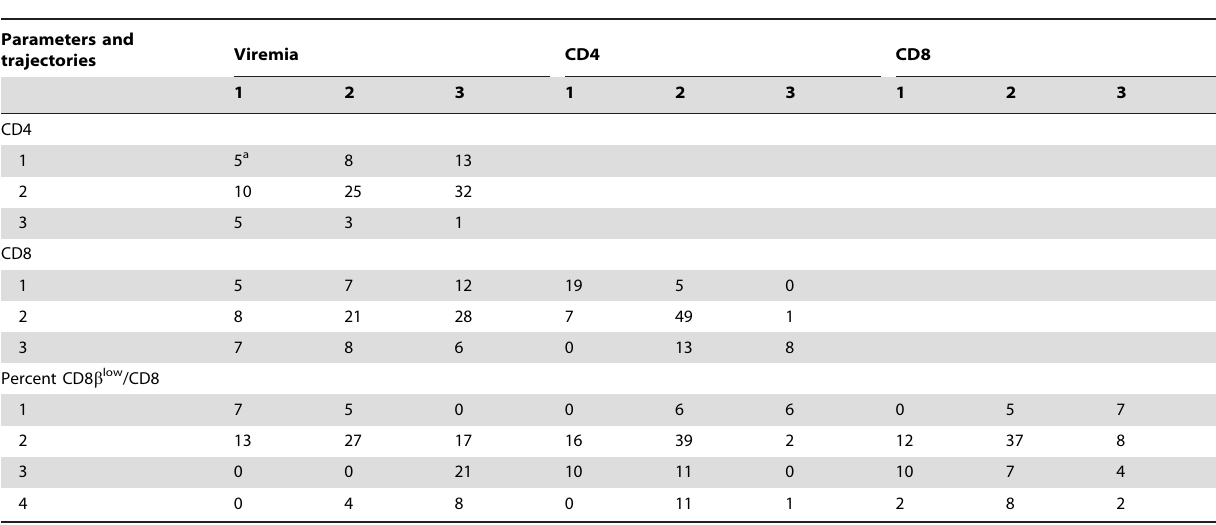
Table 5. Cross-tabulation of trajectory-groups according to viremia and changes in T-cell markers during the 12-week period after FIV